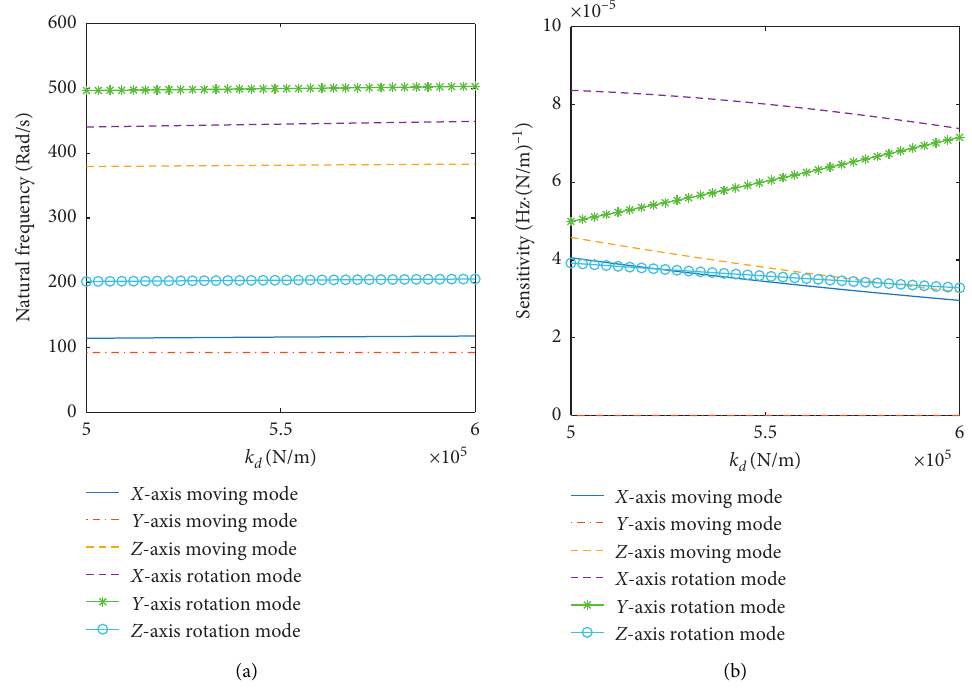
Figure 12: Curve of variation of natural frequency and its sensitivity with stiffness of outer leg 4. (a) Natural frequency. (b) Sensitivity of natural frequency to the stiffness of outer leg